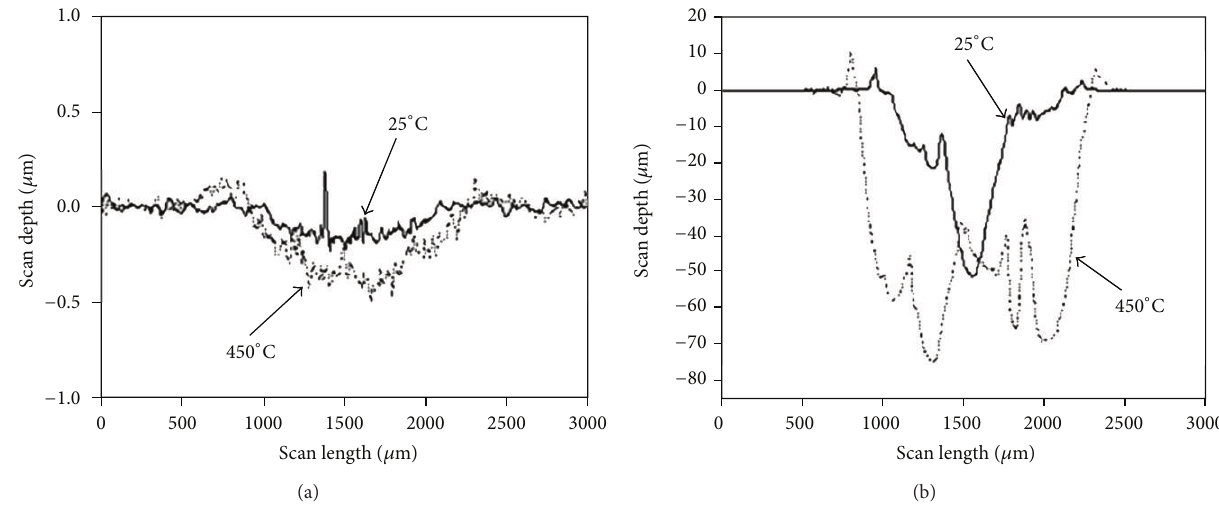
Figure 5: Wear depth profiles; (a) coating and (b) In718 at both 25 ∘ C and 450 ∘ C.